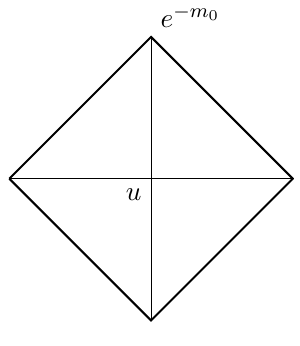
Figure 10 . Toric diagram for local P 1 × P 1